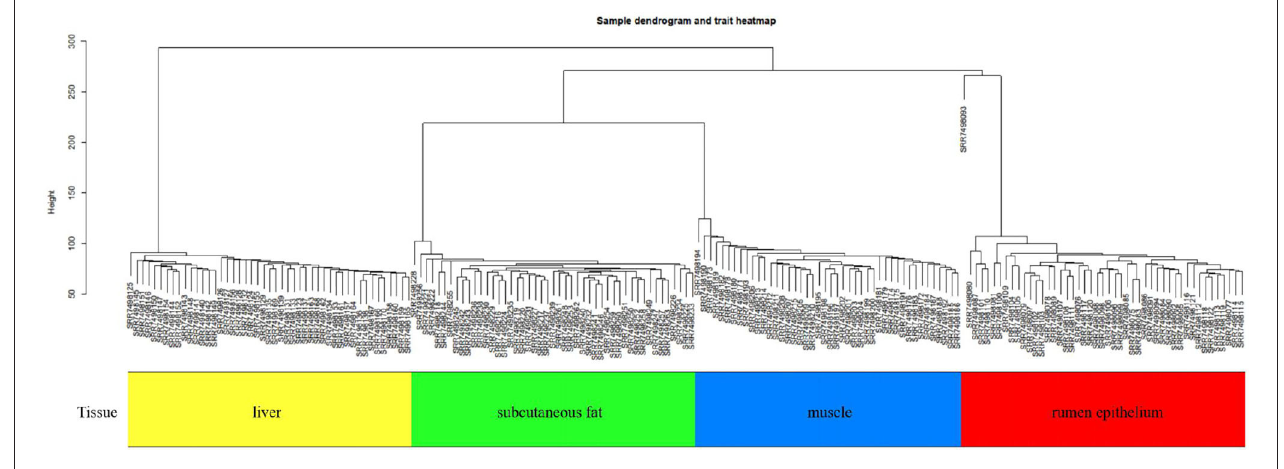
FIGURE 1 | Sample dendrogram and trait heatmap in